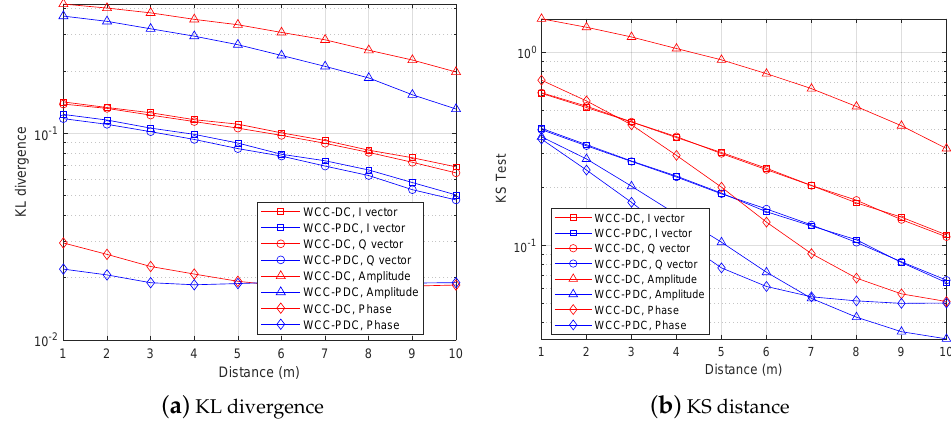
Figure 10. Detection values versus detection